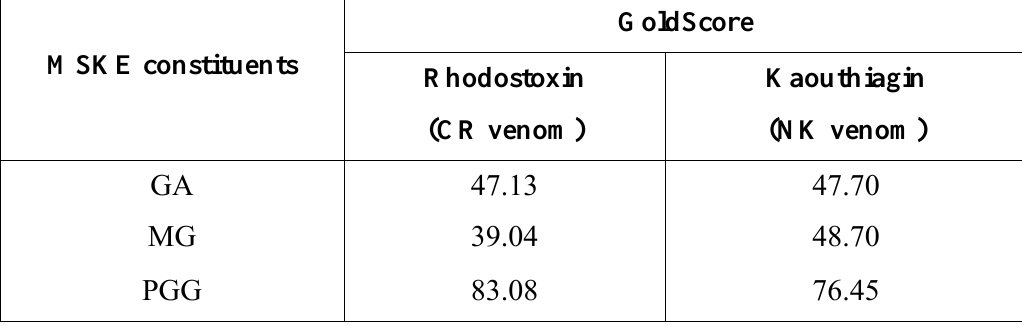
Table 1. GoldScores of ligands docked into rhodostoxin of CR and kaouthiagin of NK venoms.